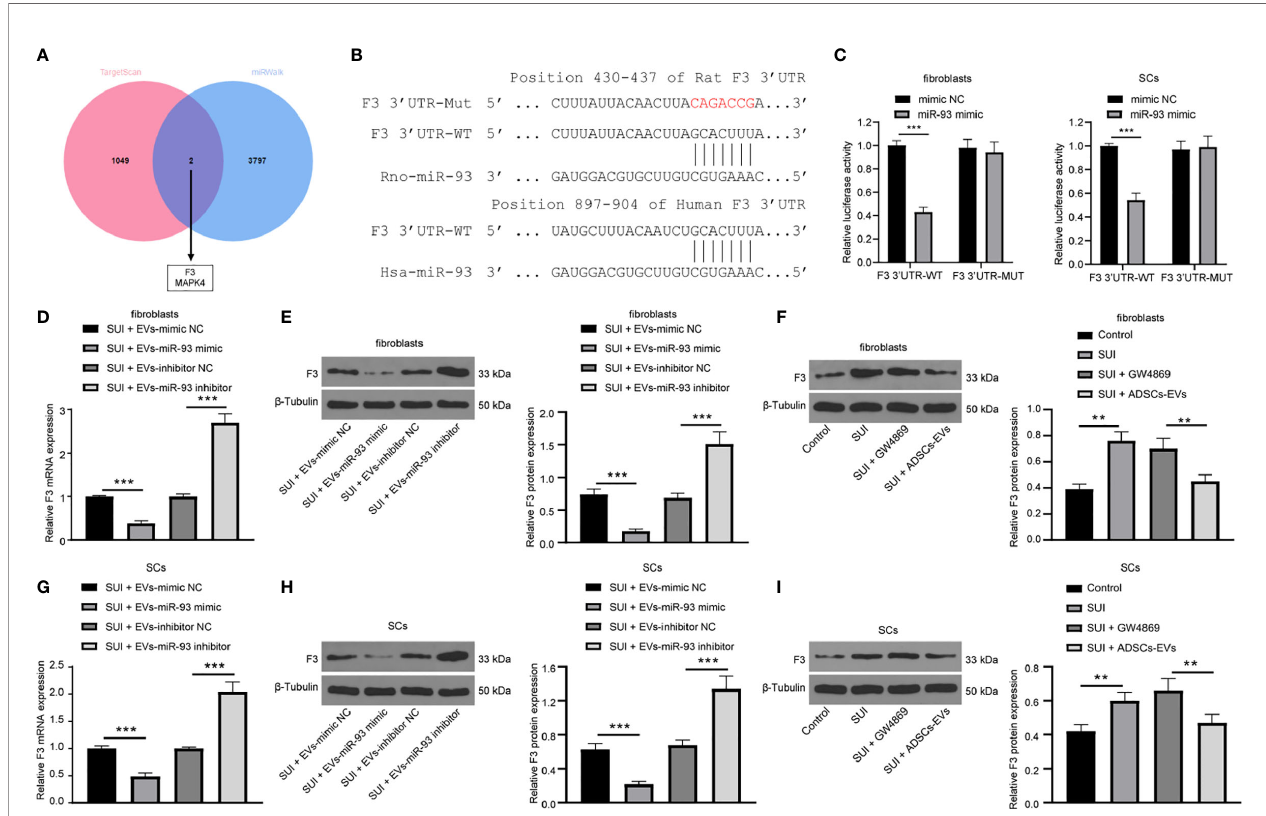
FIGURE 5 | miR-93 target F3 in EVs. (A) TargetScan and miRWalk for predicting the Venn map of the downstream target genes of miR-93. (B) TargetScan for predicting the binding sites of miR-93 and F3 3 ’ UTR. (C) Dual-luciferase reporter gene assay on the targeting relationship between miR-93 and F3 in primary fi broblasts and SCs. (D, E) RT-qPCR (D) and Western blot assay (E) were utilized to detect the mRNA and protein expression of F3 in ADSCs-EVs-treated SUI fi broblasts with the interference of miR-93 mimics or inhibitors. (F) Western blot assay was utilized to detect the protein expression of F3 in ADSCs-EVs-treated SUI fi broblasts. (G, H) RT-qPCR (G) and Western blot assay (H) were utilized to detect the mRNA and protein expression of F3 in ADSCs-EVs-treated SUI SCs with the interference of miR-93 mimics or inhibitors. (I) Western blot assay was utilized to detect the protein expression of F3 in ADSCs-EVs-treated SUI SCs. U6 and GAPDH were used as the miR-93 and F3 reference genes in the RT-qPCR data, and 2 − DD Ct was used for quantitative analysis; the Western blot assay data was normalized to the background value and the control b -Tubulin band value. N = 3. The differences between two groups were analyzed by Student ’ s t − test (C, D, E, G, H) . The differences among multiple groups were analyzed using one-way ANOVA and Tukey ’ s post hoc test (F, I) . ** P < 0.01; *** P <